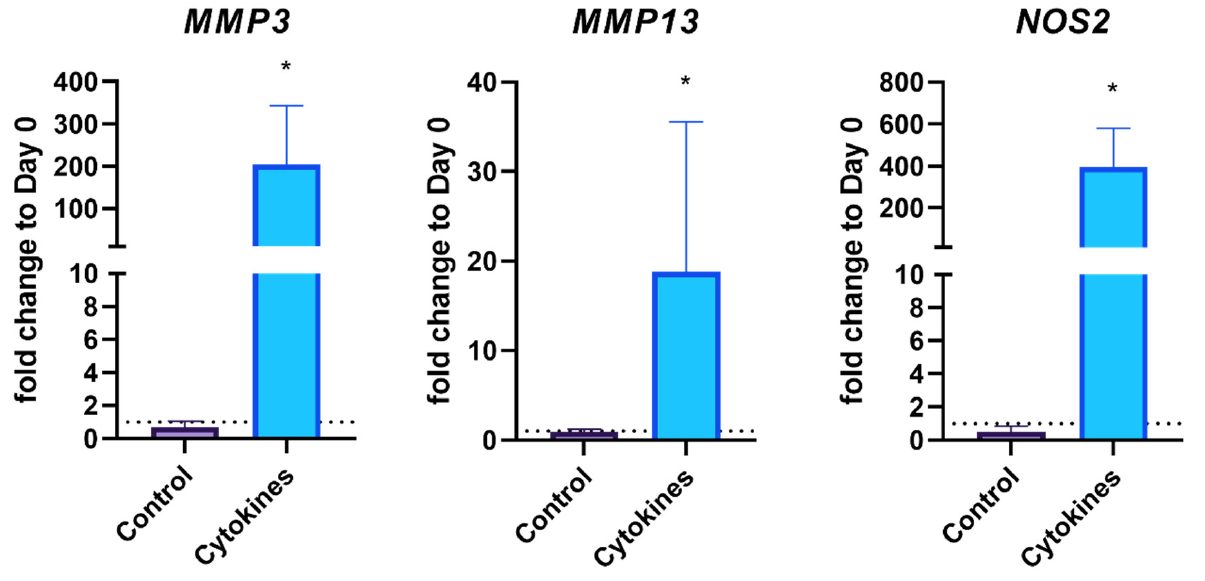
Figure 4. Expression of the catabolic genes MMP3 , MMP13 and NOS2 after three days with and without Il-1ß/IL-17 treatment. The single asterisk indicates p < 0.05. The dotted lines represent the initial gene expression on day 0.